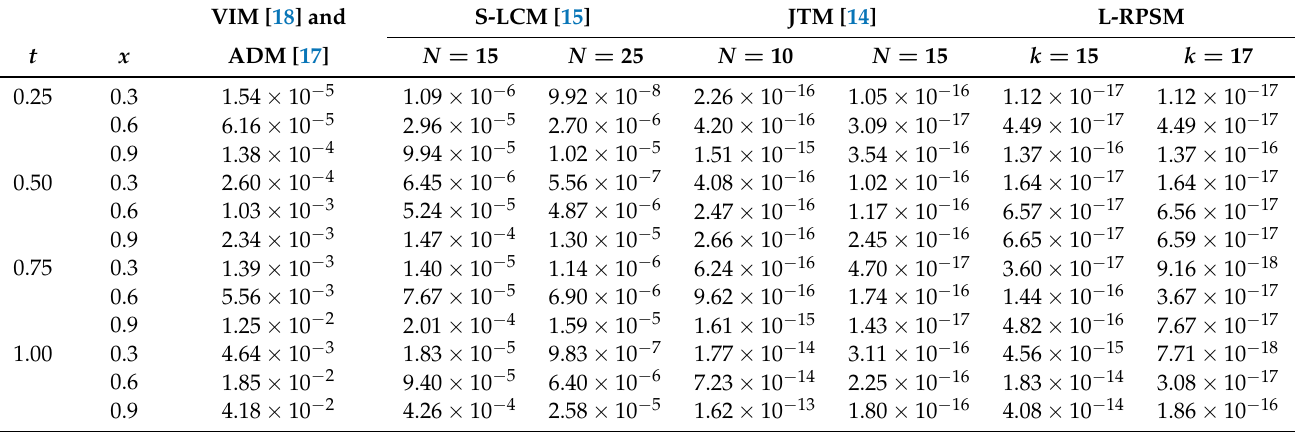
Table 2. The absolute error of the L-RPS solution obtained for Application 5 compared with various methods at α =